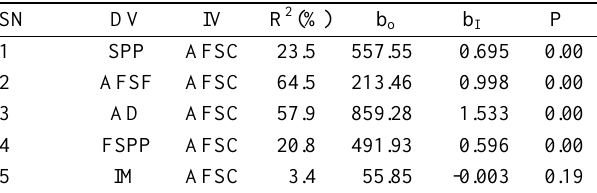
Table 9. Regression coefficient (bo, b 1 ) and coefficient of determination (R 2 ) along with respective probability values for different male reproduction parameters using AFSC as the